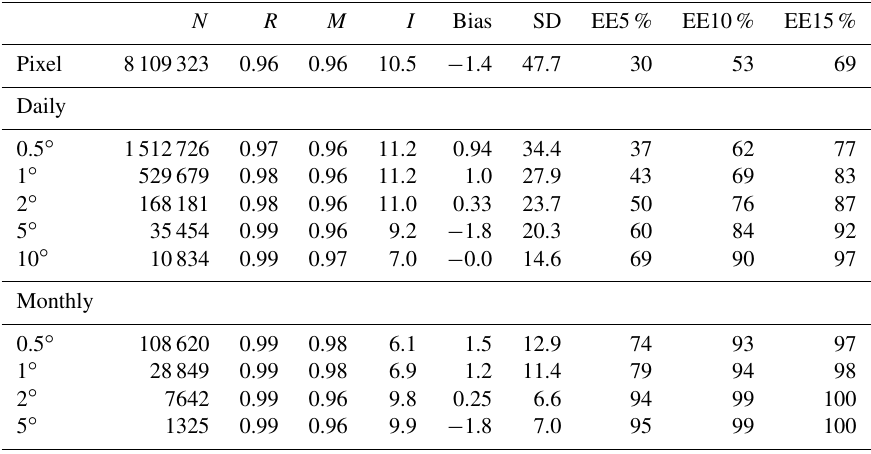
Table 2. Statistical parameters corresponding daily and monthly intercomparisons of pixel and gridded TOA SW flux data from CERES and OMI.